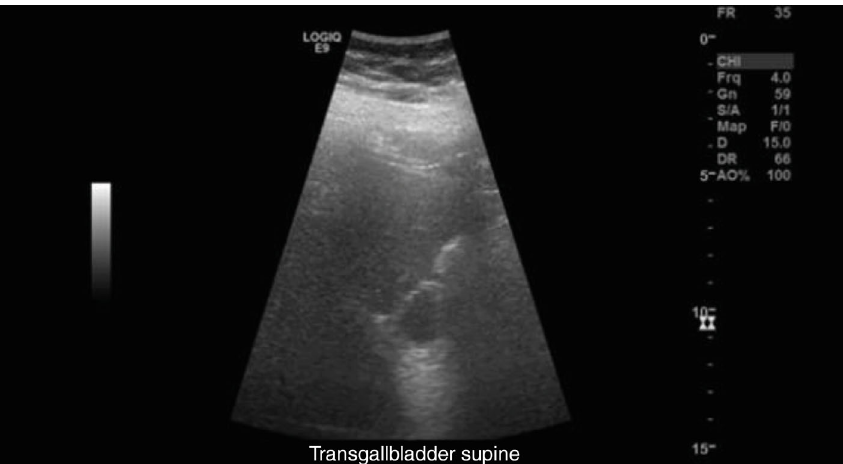
Figure 1: 35-Year-old female with biliary colic concerning for acute cholecystitis. Findings: ultrasound image reported as contracted gallbladder.